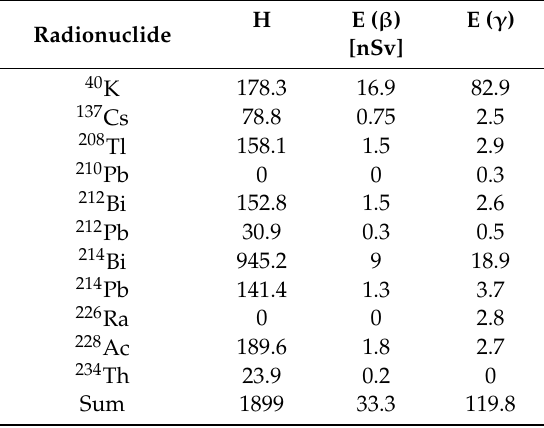
Table 3. The equivalent H dose and the e ff ective E dose obtained during a series of 15 peat mud paste applications to the skin by beta and gamma radiation during half-hour exposures. H E ( β ) E ( γ ) Radionuclide [nSv] 40 K